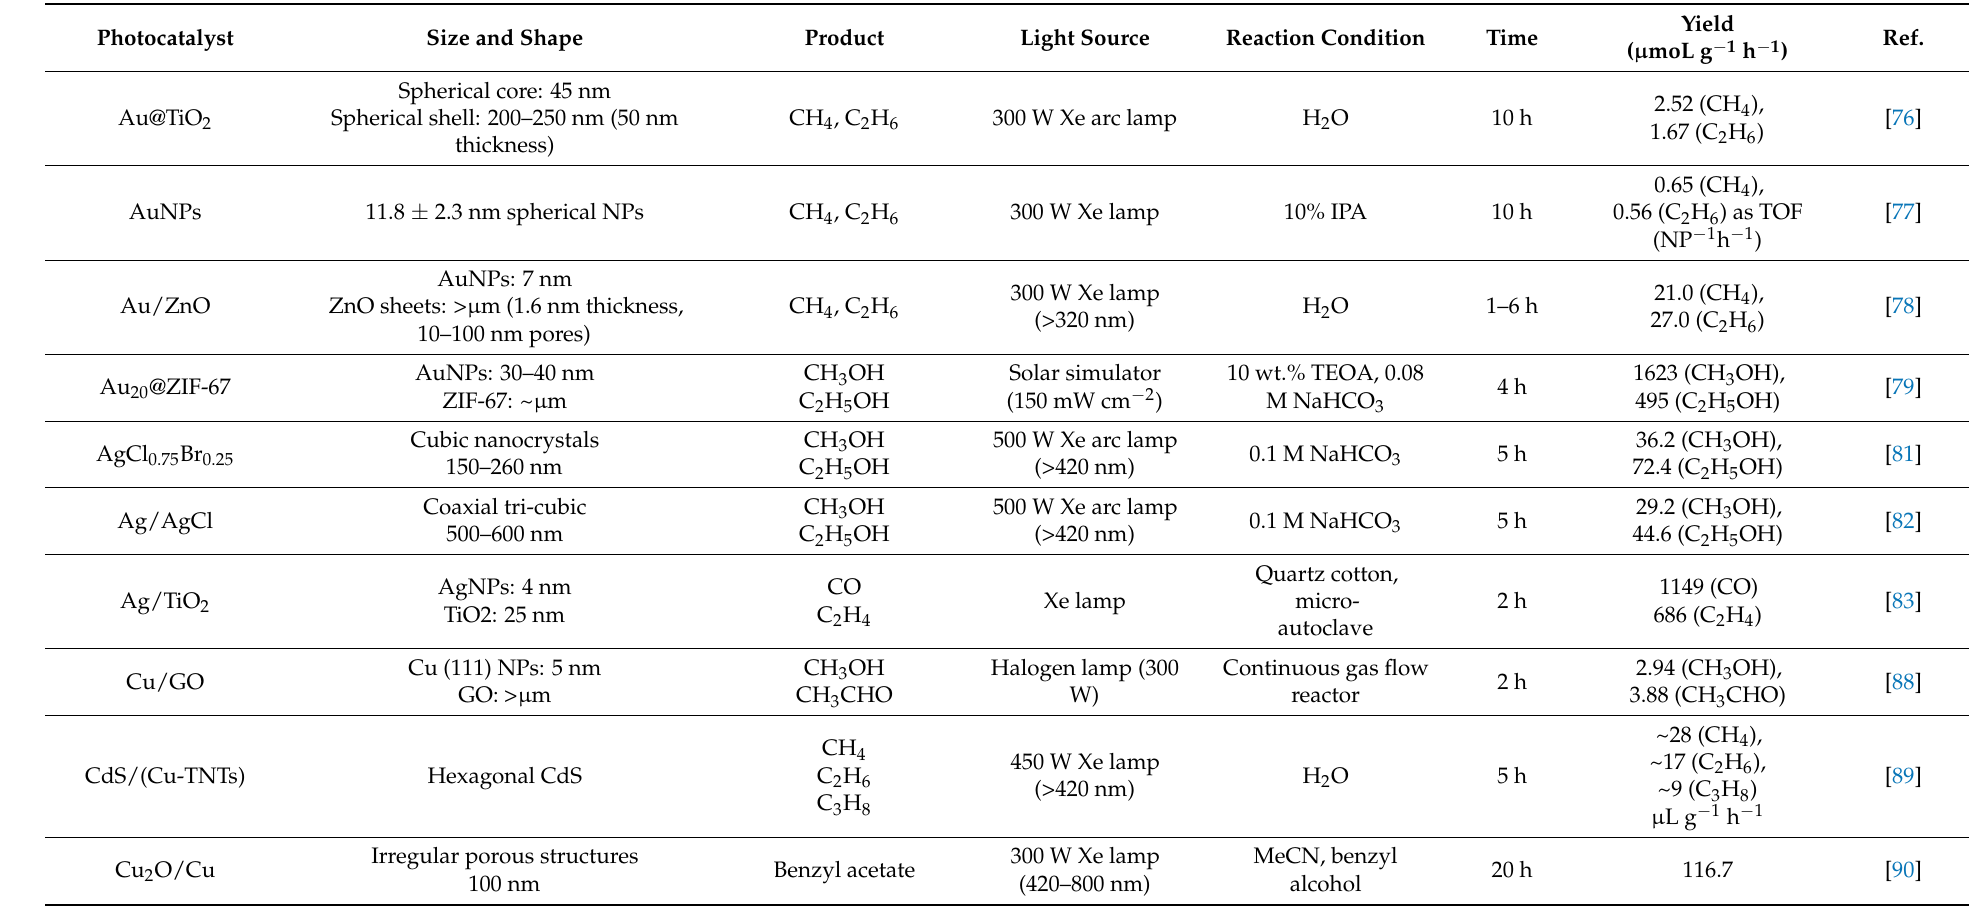
Table 1. Plasmonic hybrid nano-catalysts for various photocatalytic CO 2 conversion into multi-carbon products. AuNP-, AgNP- and CuNP-assisted photocatalysts under visible light.